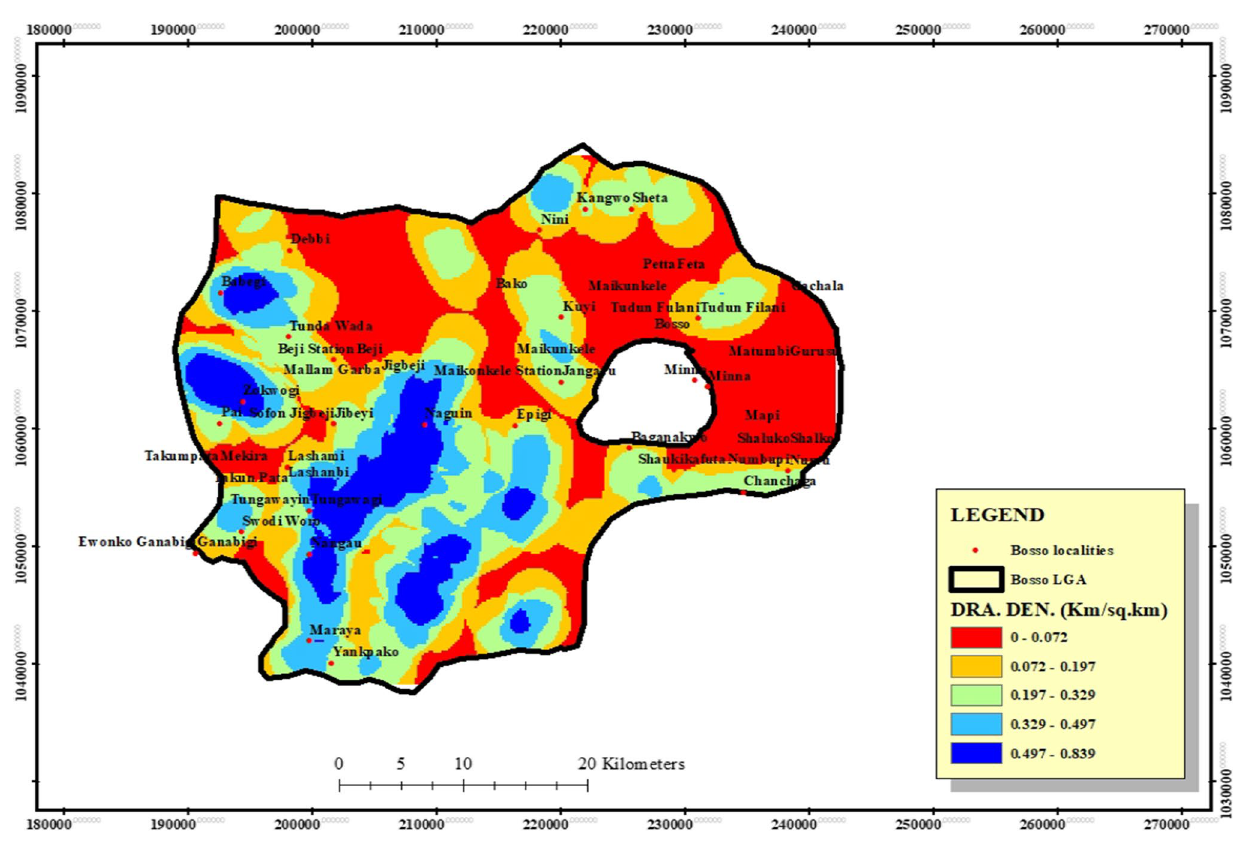
Fig. 7 Drainage density